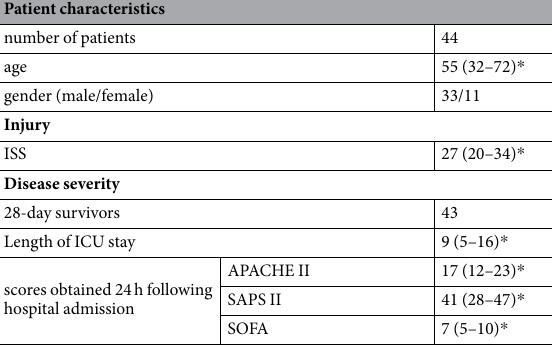
Table 1. Characteristics of the patients with major traumatic injury. * Median (interquartile range). ISS – Injury Severity Score; ICU – Intensive Care Unit; APACHE II - Acute Physiology And Chronic Health Evaluation II; SAPS II - Simplified Acute Physiology Score; SOFA - Sequential Organ Failure